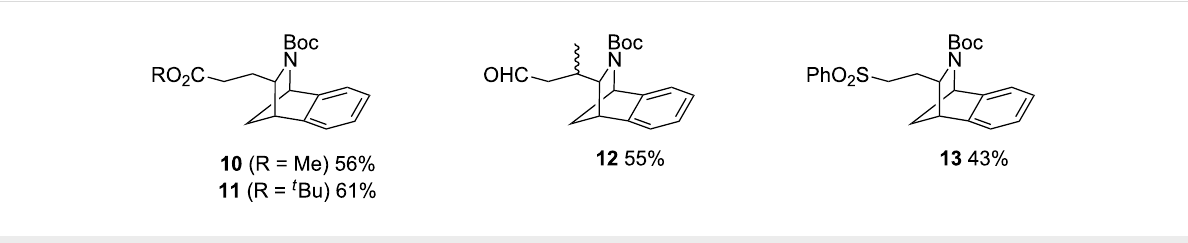
Figure 2: Other products obtained from xanthate 5 by tandem deoxygenation–rearrangement–electrophile trapping.